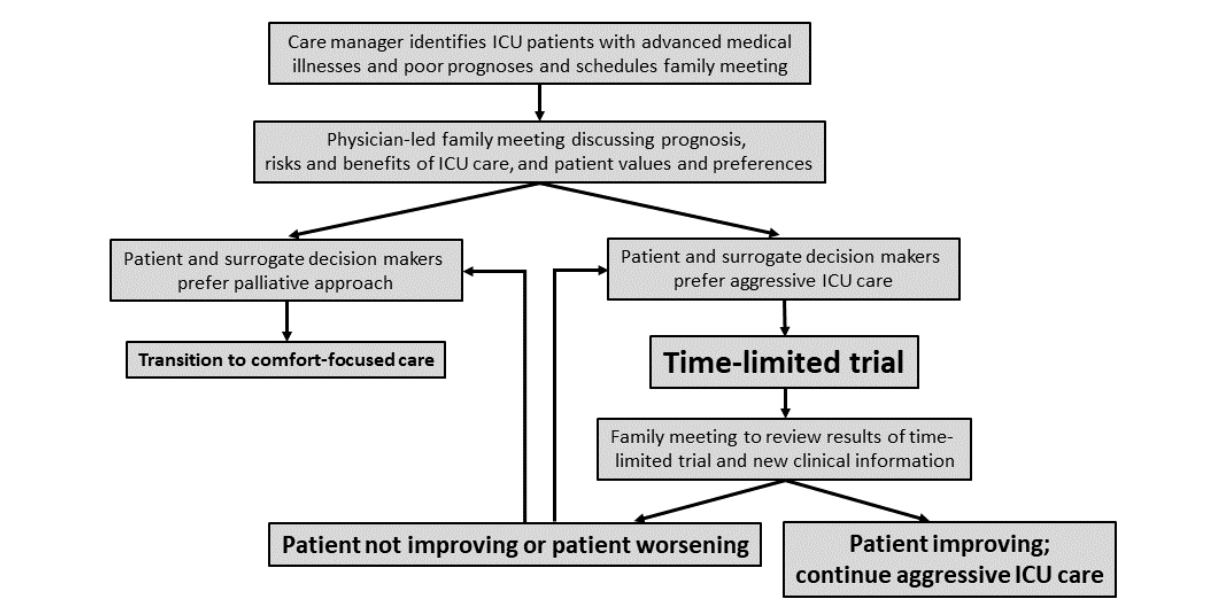
Figure 1. Implementation strategy for time-limited trials. ICU: intensive care